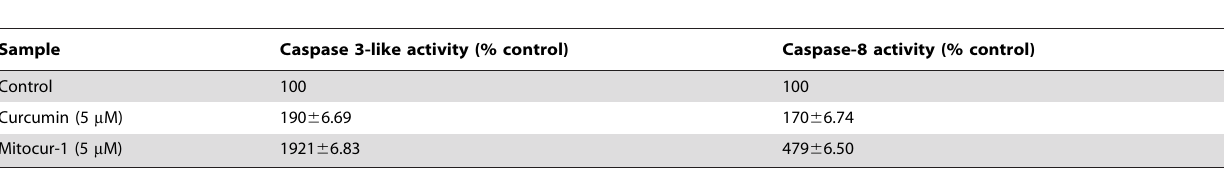
Table 3. Mitocur-1 increase caspase 3-like and caspase-8 activities in MCF-7 cells.